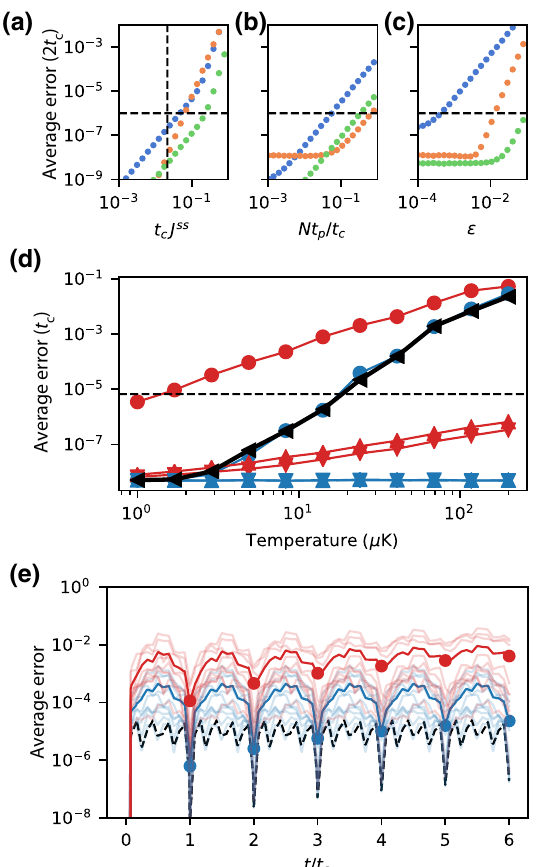
FIG. 8. (a)–(c) Storage-state DD errors at t = 2 t c for sequences 1–3 as a function of (a) sequence period, (b) pulse duty cycle, and (c) static rotation-angle error. Each plot uses the values ( t c J ss , N p t p / t c , (cid:18)) = ( 0.021, 0.025, 0 ) for the parameters not being varied. The horizontal line is at 10 − 6 , a characteristic value for the incoherent error over one two-qubit gate cycle. (d) Sensitivity to errors in sequence 2 arising from thermal motion with (blue) and without (red) matching of the sequence period to the atomic motion frequency. The red and blue circles ( (cid:14) ) show the effect of a nonmagic trap ( η = 2 × 10 − 3 ); the upward- (cid:2) ) show the effect of the position dependence pointing triangles ( (cid:3) ) show that of of (cid:5) ss ; and the downward-pointing triangles ( and J ss . The black triangles show the sum of all errors for J ss z the optimal sequence period. The dashed line shows the lifetime- limited error over one cycle, 2 × 2 π/(ωτ circ ) ≈ 7 × 10 − 6 . (e) Storage-state DD fidelity with no atomic motion (black dashed line), T = 10 μ K (blue line), and T = 50 μ K, with sequence 2 at the optimal period. The light traces show the evolution for indi- vidual randomly sampled trajectories, and the dark traces show the average. In (d),(e), a circ = 16 μ m to match the condition t π = 4 × 2 π/ω with ω = 2 π × 100